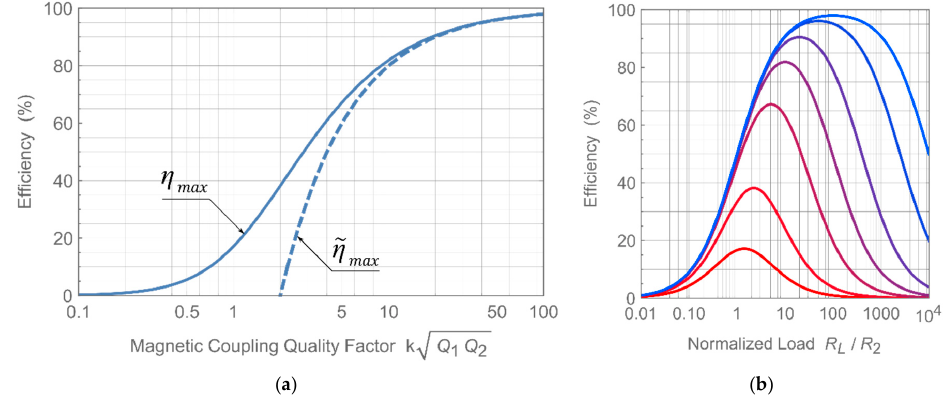
Figure 12. Efficiency in a serial-serial (SS)-compensated inductive wireless power transfer (IWPT): ( a ) maximum achievable efficiency with optimal load, as a function of 𝑘 (cid:3493)𝑄 (cid:2869) 𝑄 (cid:2870) ; ( b ) efficiency as a function of the normalized load.